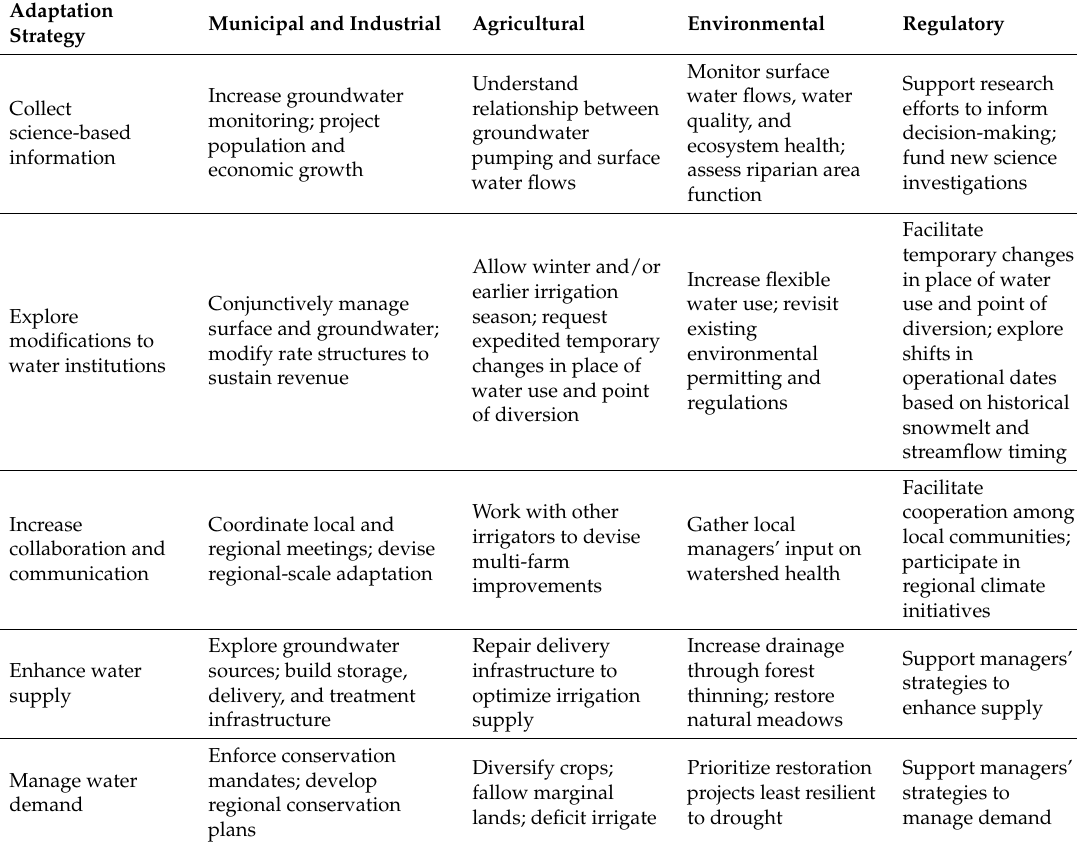
Table 4. Examples of adaptation strategies identified by water use.